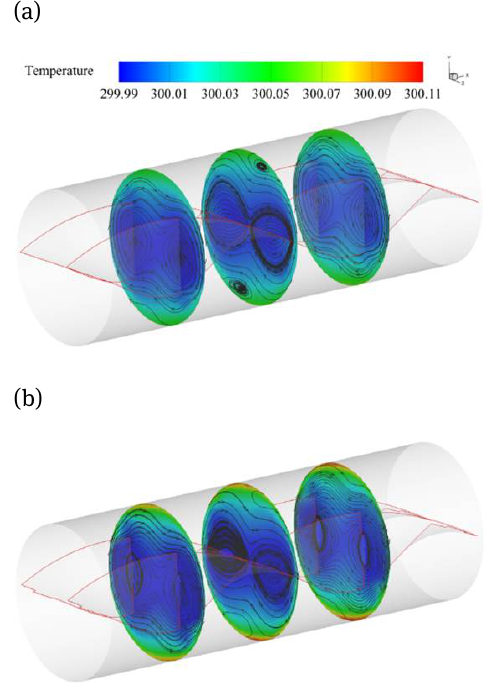
Figure 5: Streamline and fluid temperature in cross-section view of tapes: (a) dual twisted tapes (DTs); (b) peripherally-cut dual twisted tapes (PDTs: l / y = 0.5 ).